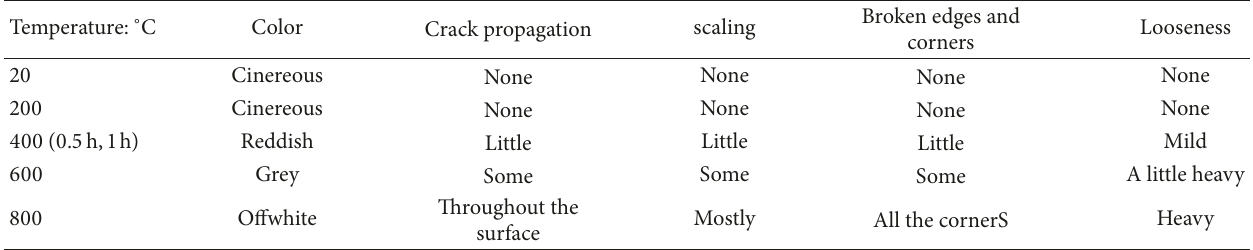
Table 2: Appearance characteristics of HSC after exposure to high temperatures and then room temperature